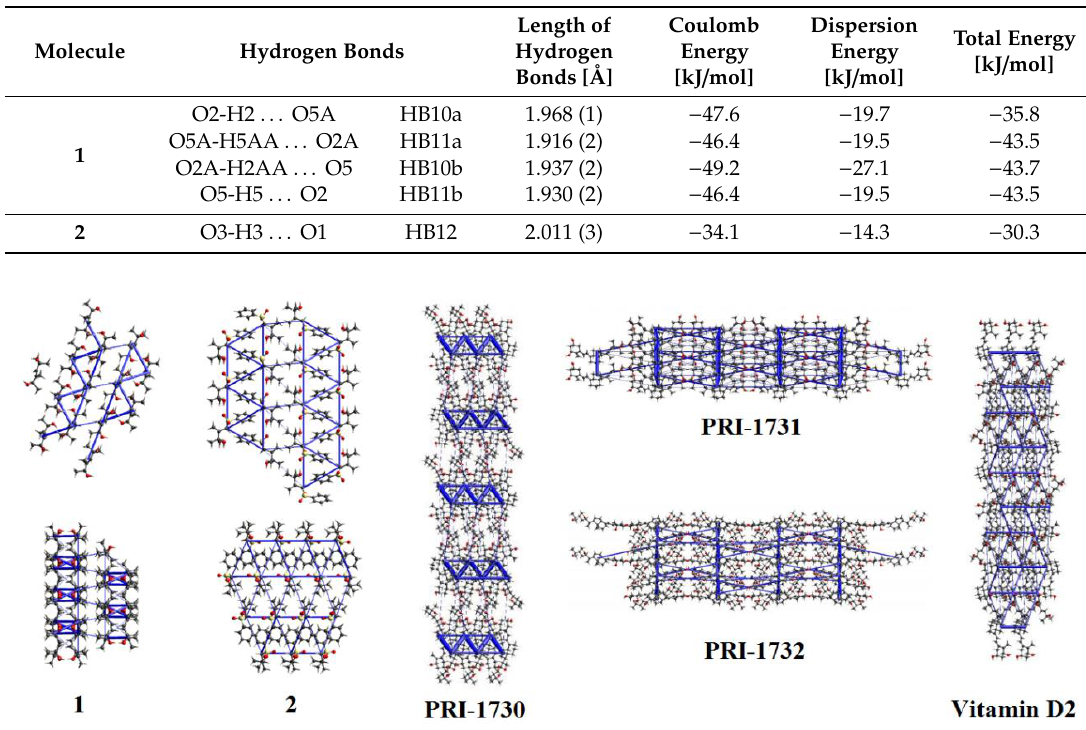
Table 3. Results of energy framework calculations for 1 and 2 and lengths of the analysed hydrogen bonds.